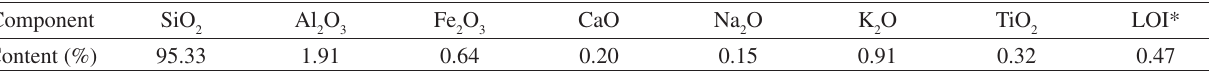
Table 1. Equivalent mineral oxide composition of the sand used in the mortars.